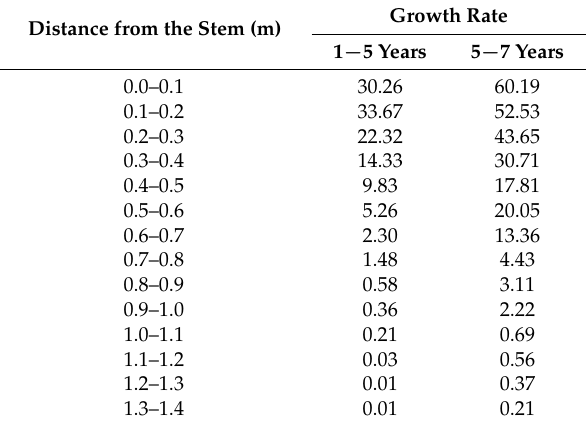
Table 8. The growth rate of the total root biomass in each soil layer in the horizontal